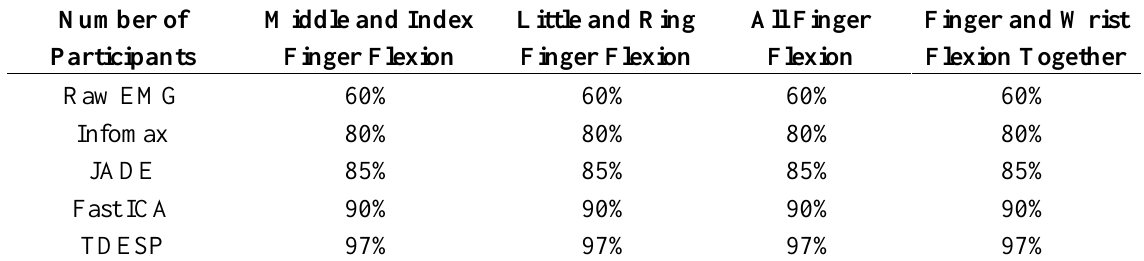
Table 6. Performance of four types ICA algorithm (percentage) for isometric hand gesture Identification